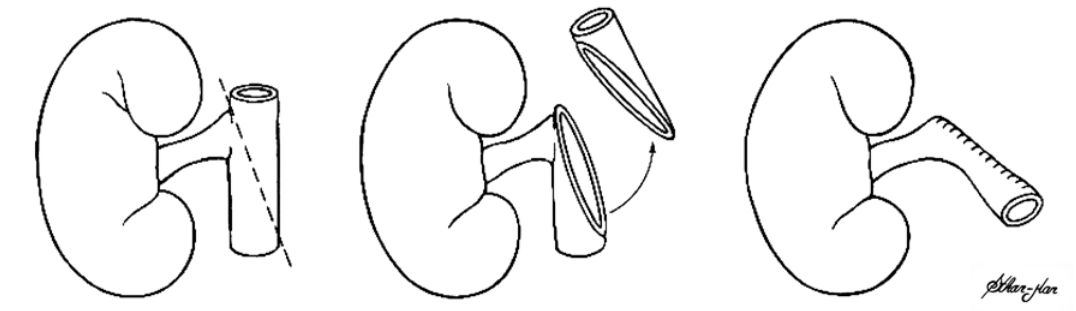
Figure 2 – Elongation of the right renal vein with segment of the vena cava.